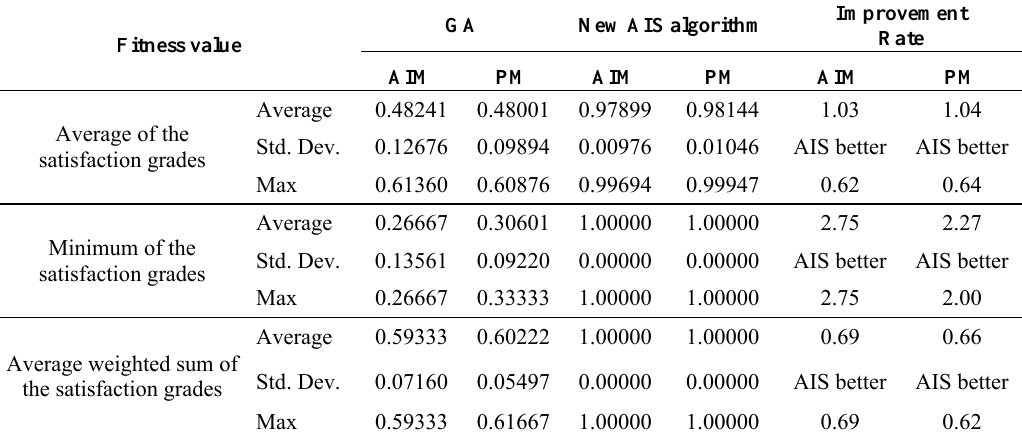
Table 3. Average and best values of satisfaction grades for AIS and GA GA New AIS Fitness value